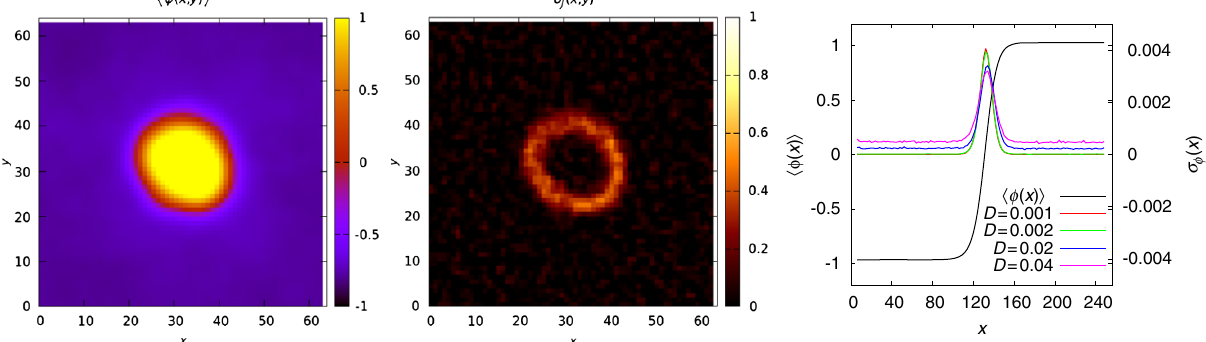
FIG. 1. Left panel: Density map of a fluctuating phase-separated droplet in Active Model B in 2D. Center panel: Local contribution to the entropy production σ ð r Þ showing a strong contribution at the interfaces. Right panel: Density and entropy production for a 1D system comprising a single domain wall, for various noise levels D ≪ a 2 2 = 4 a 4 . The entropy production is strongly inhomogeneous, attaining a finite value as D → 0 at the interface between dense and dilute regions and converging to zero in the bulk in this limit. Values of the parameters used are a 2 ¼ − 0 . 125 , a 4 ¼ 0 . 125 , κ ¼ 8 , and λ ¼ 2